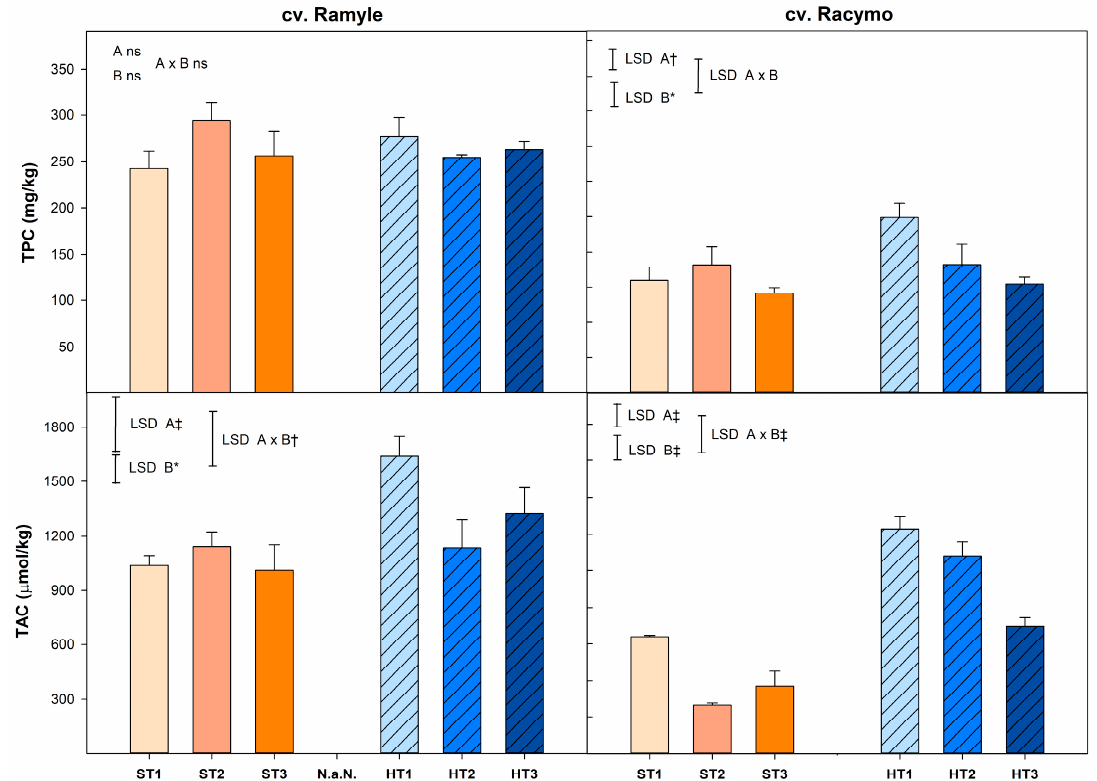
Figure 7. Total phenolic content (TPC) and total antioxidant capacity (TAC) of two tomatoes (cvs. Ramyle and cv. Racymo) under di ff erent irrigation treatments (T1: desalinated seawater with low electrical conductivity (EC); T2: well / desalinated water, intermediate EC; and T3: well water with high EC) and cultivation systems (traditional soil system, S; hydroponic, H) ( n = 3 ± SD). The uppercase letters A and B denote cultivation system and irrigation treatment, respectively. ns, *, † , and ‡ significance for p ≤ not significant, 0.05, 0.01, and 0.001, respectively.